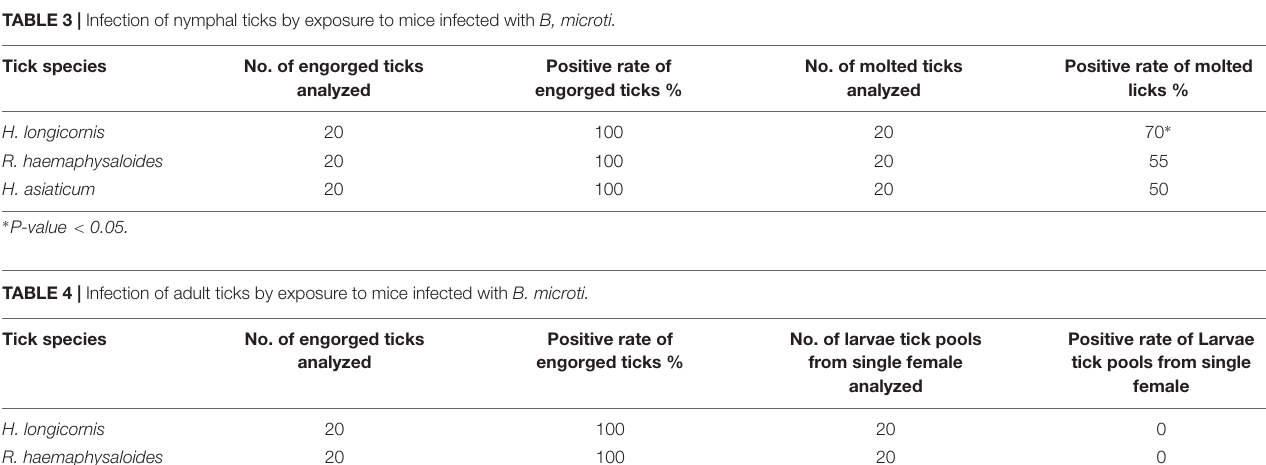
Positive rate of engorged ticks %